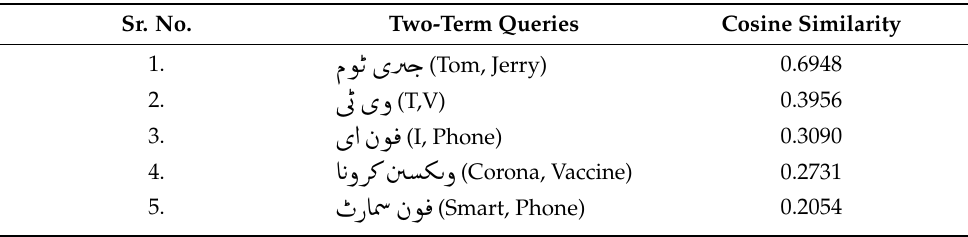
Table 13. Cosine similarity of word vectors generated from W2V for sample two-term queries. Sr.